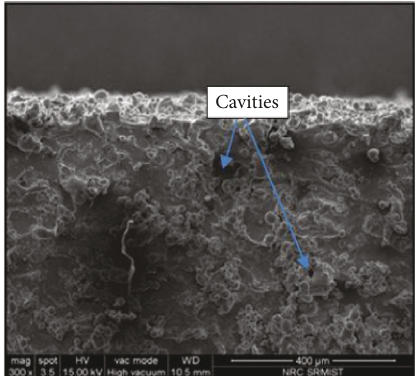
Figure 6: Machined surface using zinc-coated tool with 300x magnification.